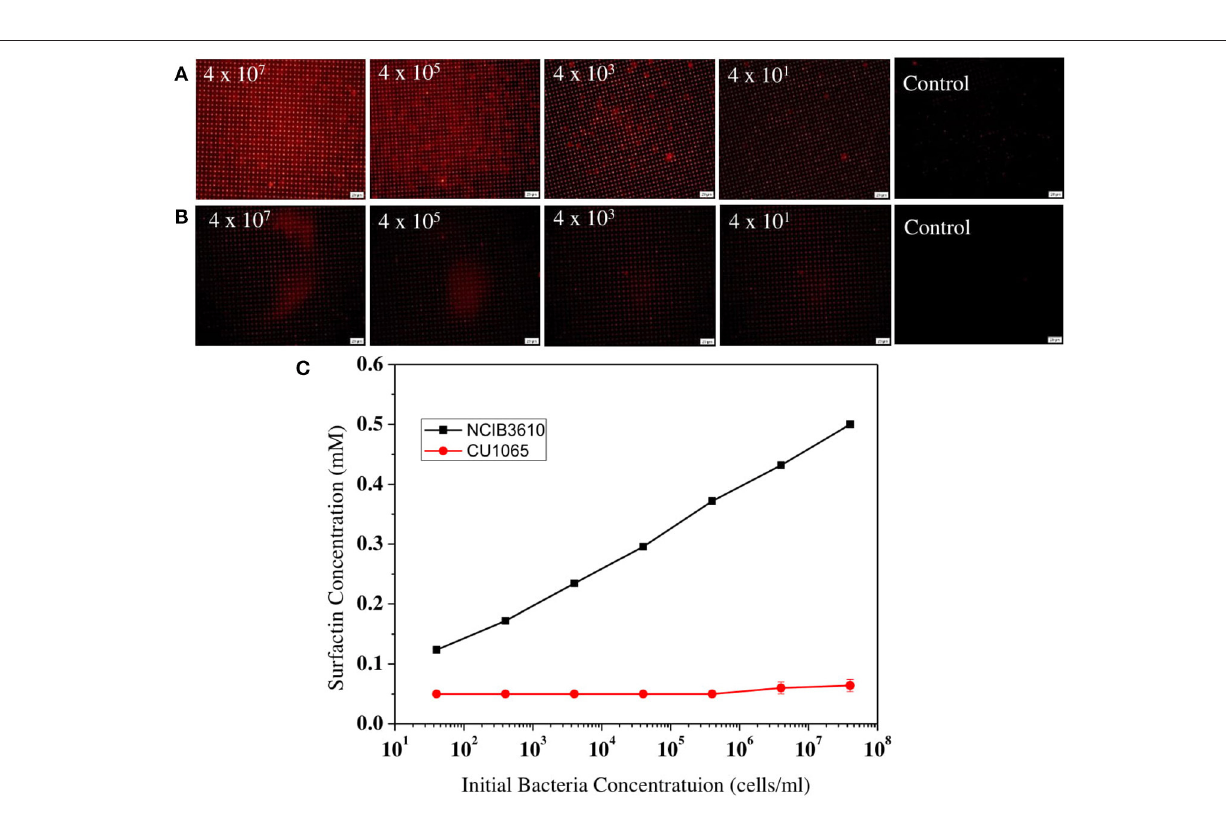
FIGURE 7 | Comparison of the surfactin-detecting sensitivities between B. subtilis NCIB3610 and B. subtilis CU1065. The fluorescence images of sensor platform after exposed to media supernatants of (A) NCIB3610 strain and (B) CU1065 strain, (C) Plot of 3D-PDA-PDMS measurement of surfactin production levels depending of the initial cell